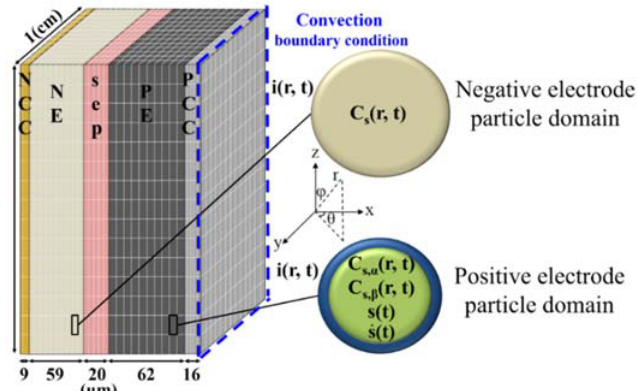
Figure 3. Computational domain and mesh configuration generated for the 1 cm 2 experimental cell of Srinivasan et al. [9], and the relevant dimensions and boundary conditions. The microscopic spherical particle model is applied to every grid point in the negative and positive electrode regions and solved in the particle domain.